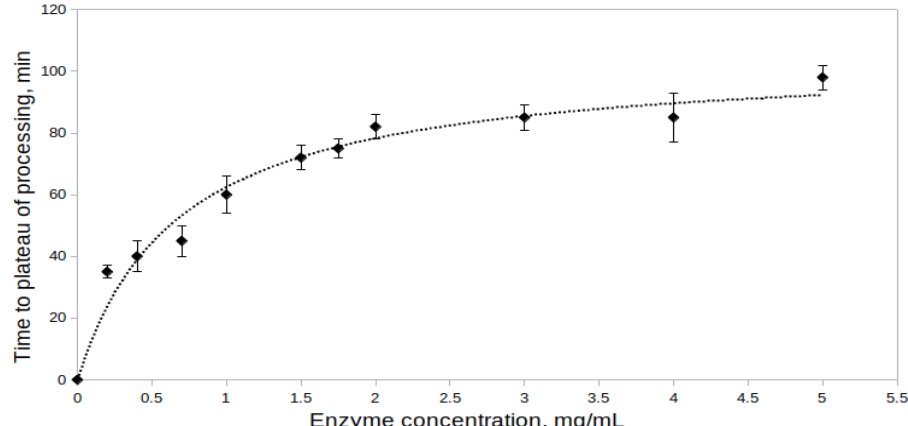
Figure 2. Effect of proenzyme concentration in the processing reaction mixture on the processing of rpTcCathL1. The activity of the mature rTcCathL1 was measured with 0.5 mM Glp-Phe-Gln-pNA in 0.1 M UB, pH 5.6 in the presence of 6 mM cysteine and 1 mM EDTA.